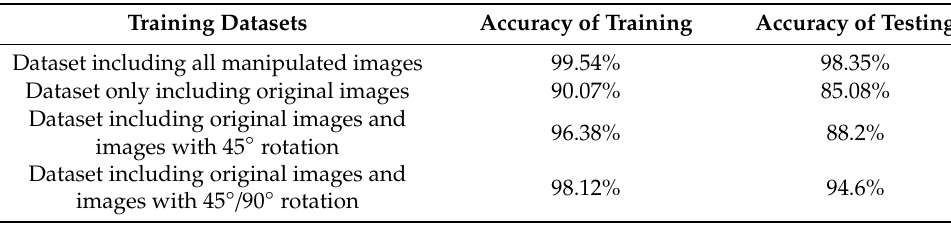
Table 7. Comparison of the results in di ff erent training